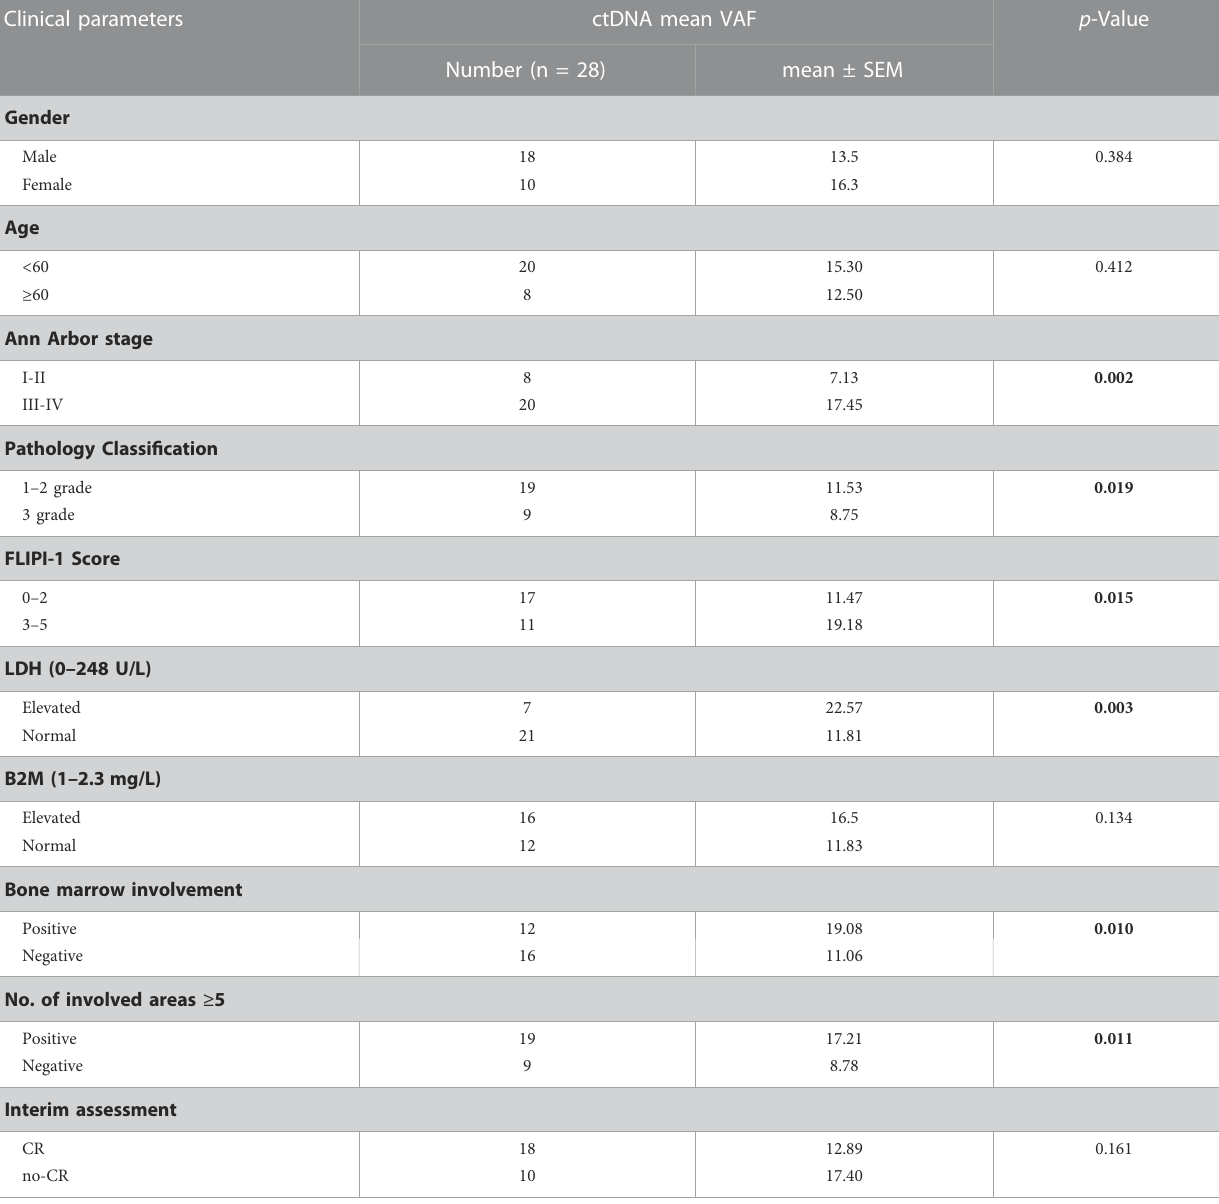
TABLE 2 Correlation between clinical indicators and the ctDNA levels. Clinical